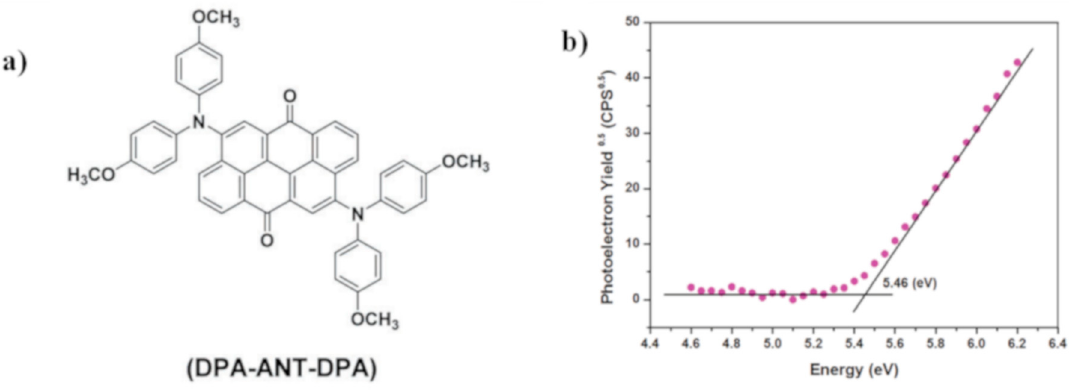
Figure1. ( a )ThechemicalstructureofDAD(4,10- bis ( bis (4-methoxyphenyl)amino)naptho[7,8,1,2,3-nopqr] tetraphene-6,12-dione); ( b ) The photoelectron spectroscopy in air (PESA) of